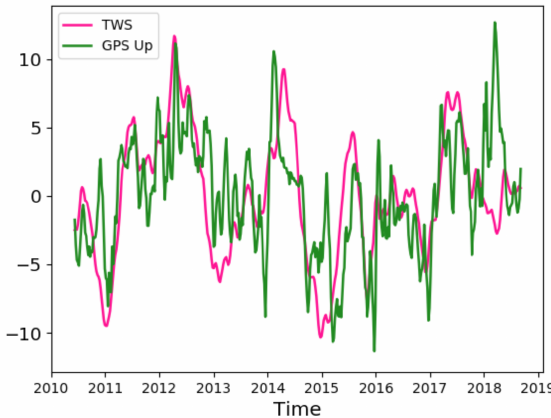
Figure 13. Time components of the first SVD of the residuals of the variable pair (monthly values) TWS (magenta line) and Up coordinate (green line).